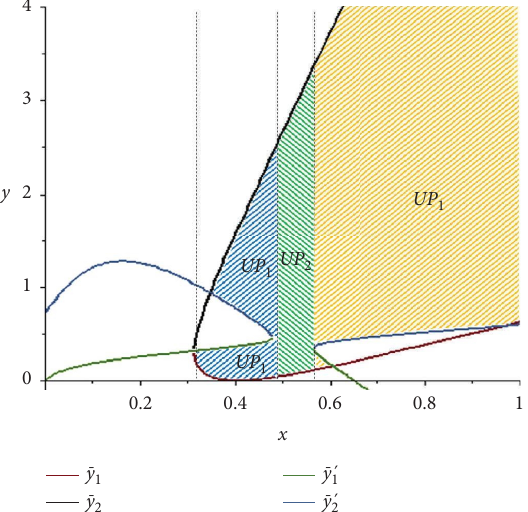
Figure 2: Te diferent regions of Z